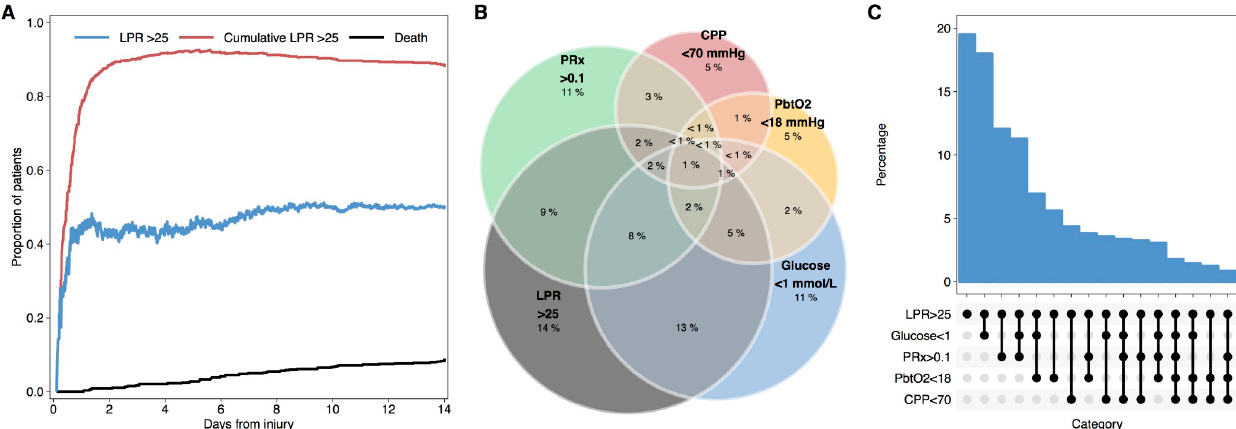
Fig 5. LPR elevation and associated physiological derangements. Survival based curves (A) indicating likelihood of LPR > 25 and the cumulative incidence of at least one epoch of LPR > 25. Euler plot (B) showing prevalence of abnormalities in brain glucose, CPP, PRx, and PbtO 2 (defined by the thresholds described in the text) during episodes of elevated LPR. Alternative representation as ‘Upset’ plot (C) showing differing frequency of permutations of physiological abnormalities (as indicated in the panel beneath the x-axis) associated with elevated LPR.